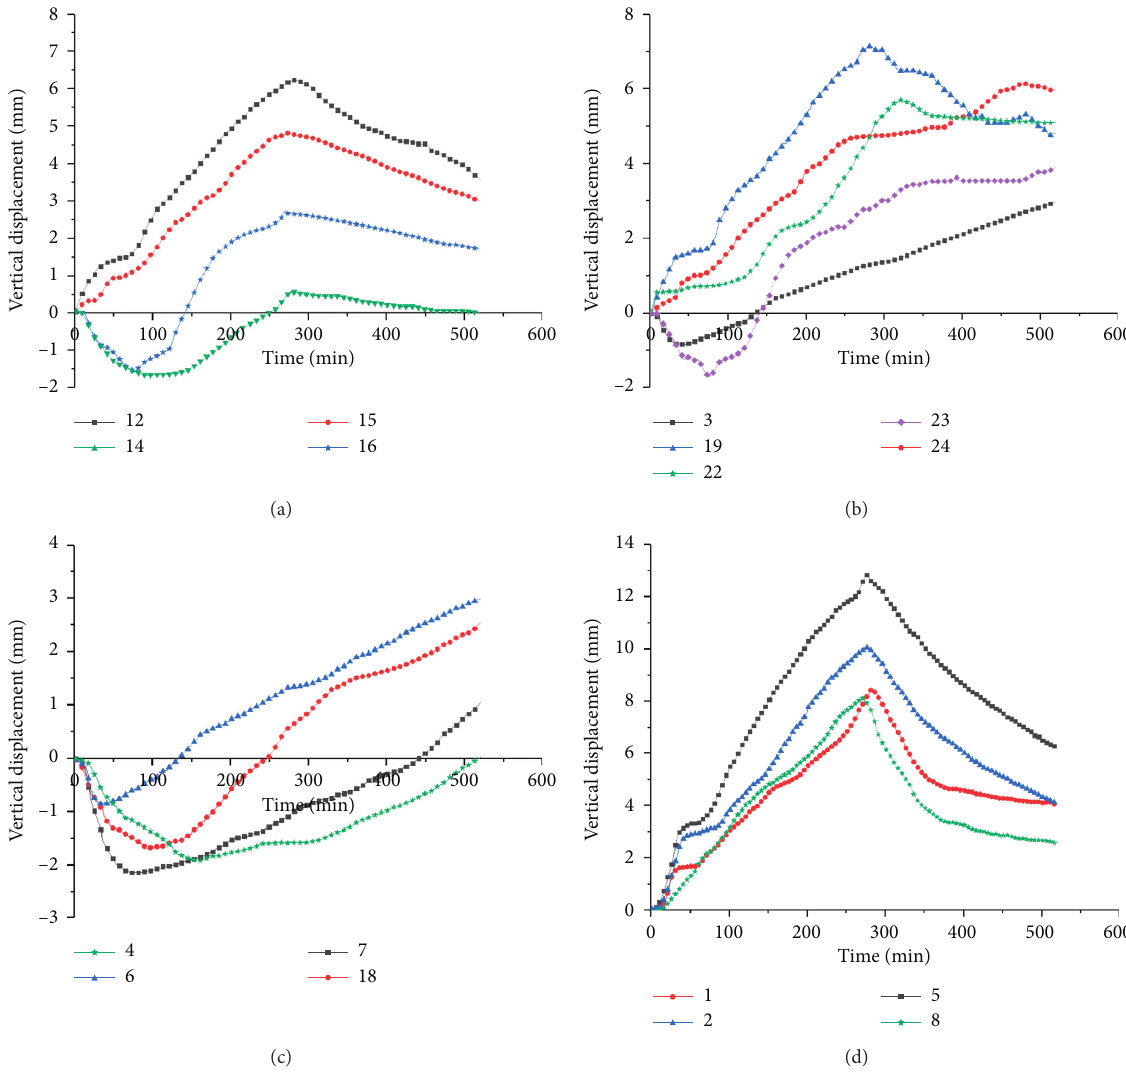
Figure 17: Vertical deflections-time relationship of the AMH slabs. (a) Panel A; (b) panel B; (c) frame hidden girders; (d) edge